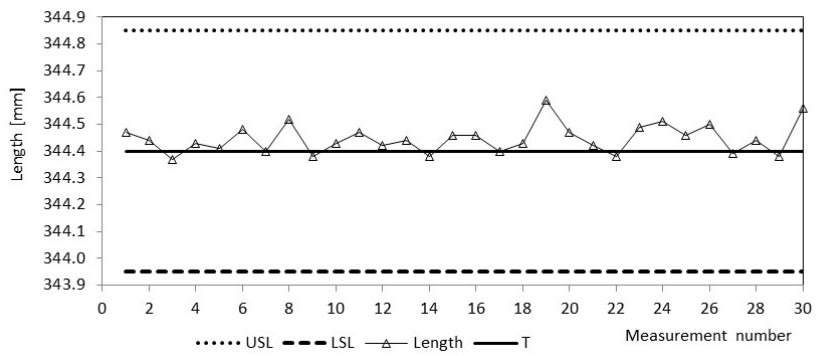
Figure 15. Histogram and frequency function for the length parameter, first day [20].